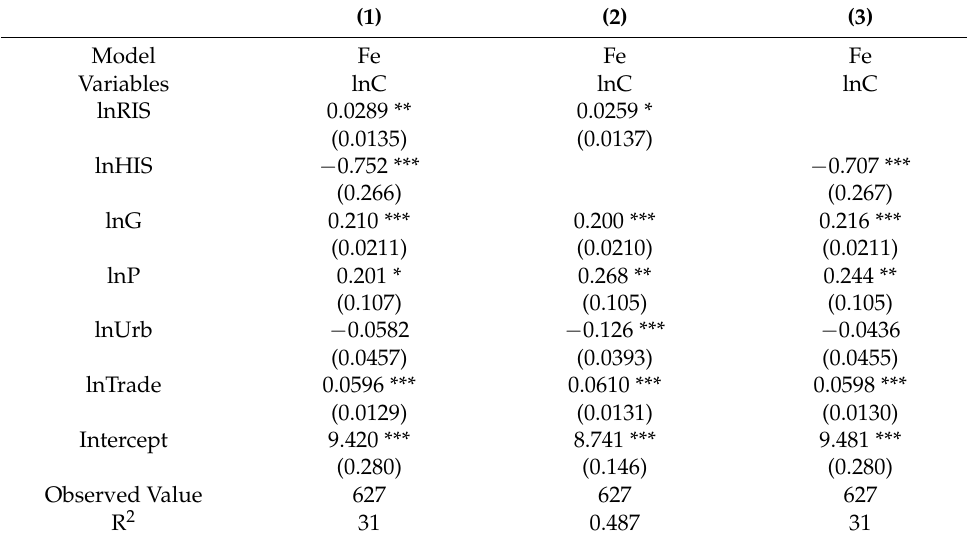
Table 4. Estimated results of robustness